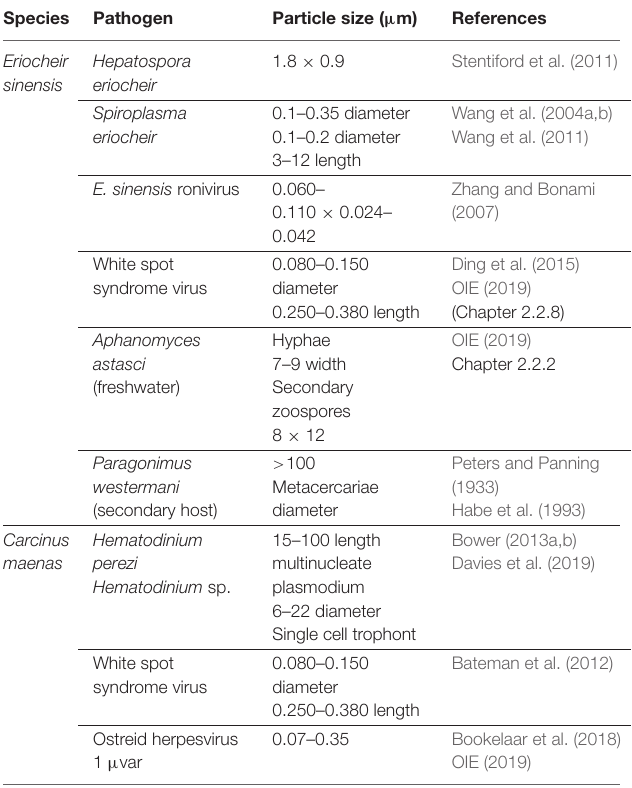
TABLE 3 | Notable pathogens and parasitic invertebrates associated with Eriocheir sinensis and Carcinus maenas . Species